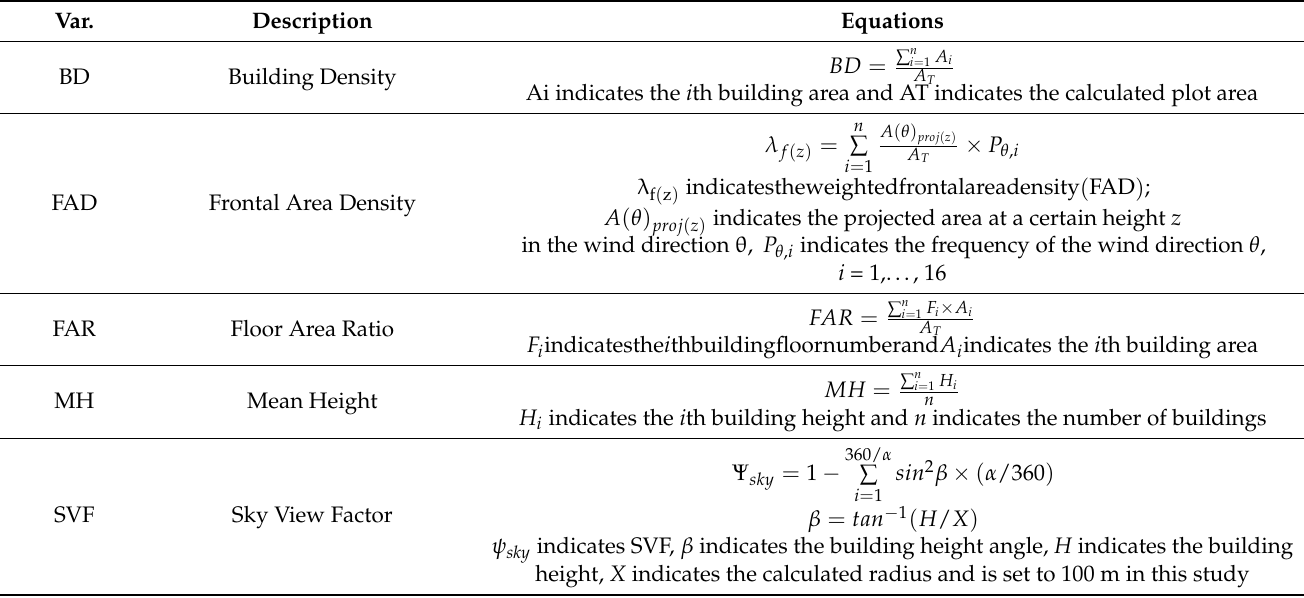
Table 2. Urban spatial morphological parameters required for LST